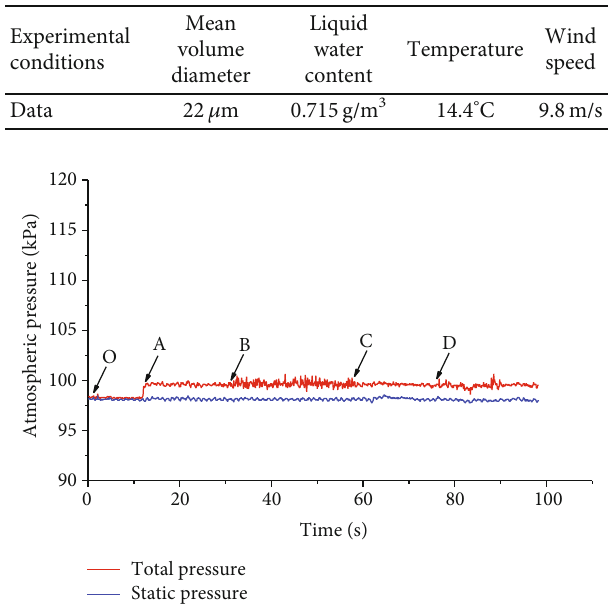
Figure 10: Total and static pressure outputs under normal temperature. O – A: the entire detection system is stationary. A-B: after the experimental environment reaches a stable state, the L- shaped pitot tube is placed into the ice wind tunnel at point A such that the total pressure hole is facing the incoming wind direction. After point B, the pitot tube is retracted at point B. C – D: the A – B operation is repeated. Table 6: Experimental parameters for opening the spray system at normal